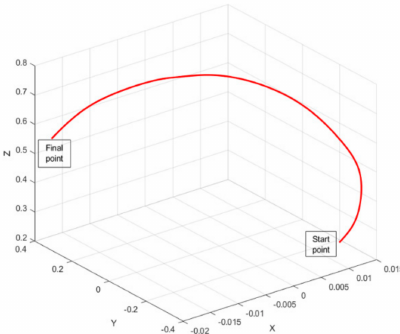
Figure 9. Original trajectory visualization.